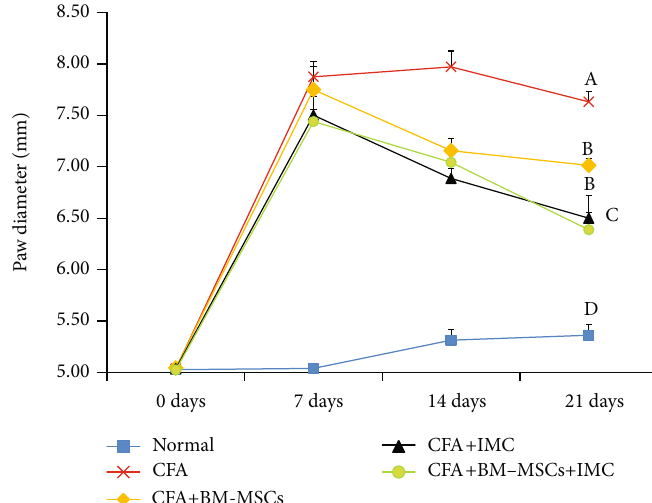
Figure 1: E ff ect of BM-MSCs and/or IMC on the right hind paw diameter (mm) in CFA-induced rats. Means, which have di ff erent symbols, A, B, C, and D, are signi fi cantly di ff erent at p < 0 : 05 .